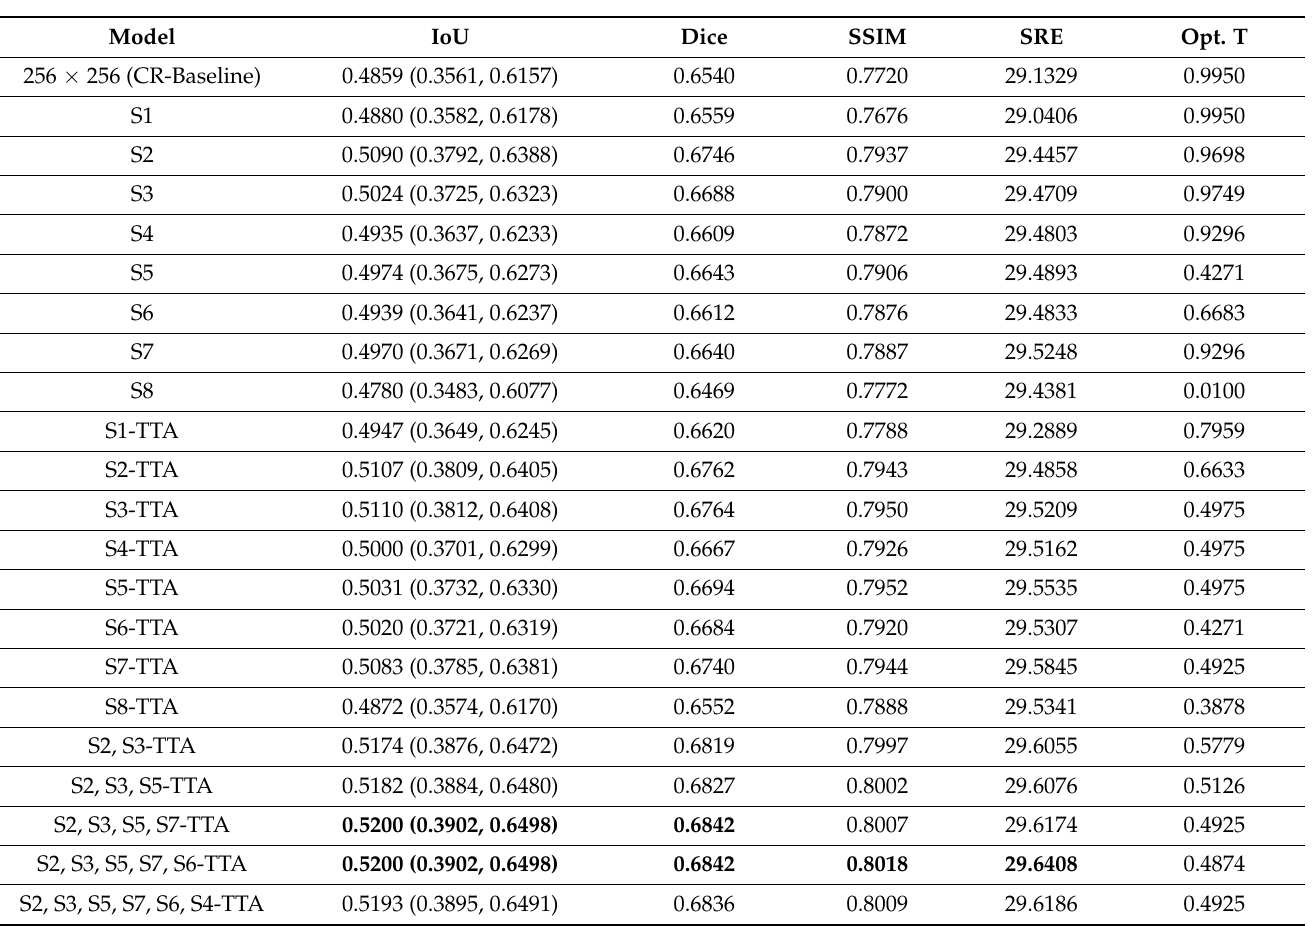
Table 6. Performance achieved by each model snapshot before and after applying the optimal TTA and averaging the snapshots after TTA. Bold numerical values denote superior performance in respective